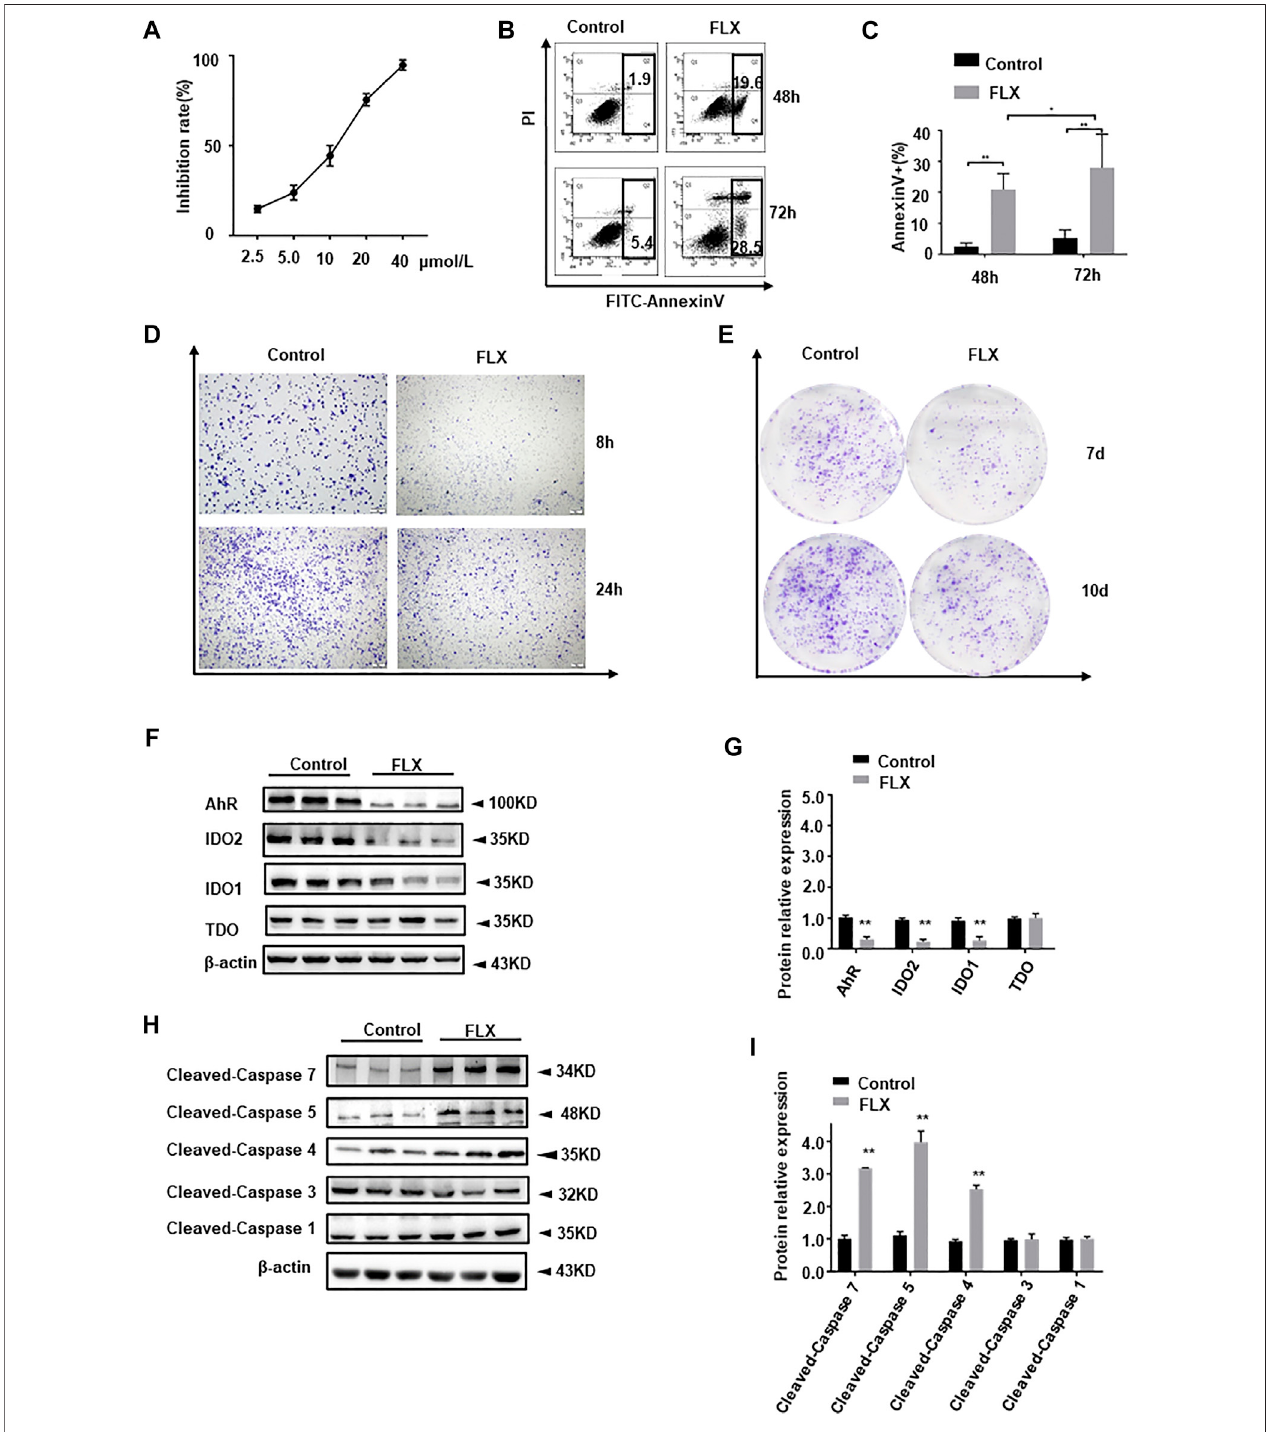
FIGURE9| Anticancereffectof fl uoxetineinA549cells. (A) Growth-inhibitioncurvesofcells. (B,C) CellapoptosisofA549cells. (D) CellmigrationofA549cells. (E) Clone formation of A549 cells. (F,G) Representative and statistical analysis western blotting bands of tryptophan metabolic enzymes in A549 cells. (H,I) Representative and statistical analysis western blotting bands of apoptosis-related protein in A549 cells. Data were expressed as mean ± SD. * p < 0.05, ** p < 0.01.